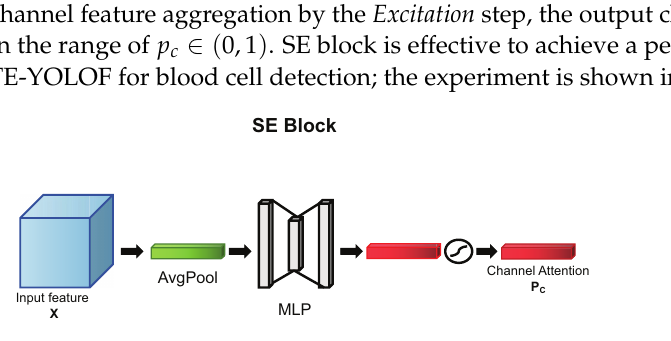
Figure 6. The channel attention mechanism used in SENet